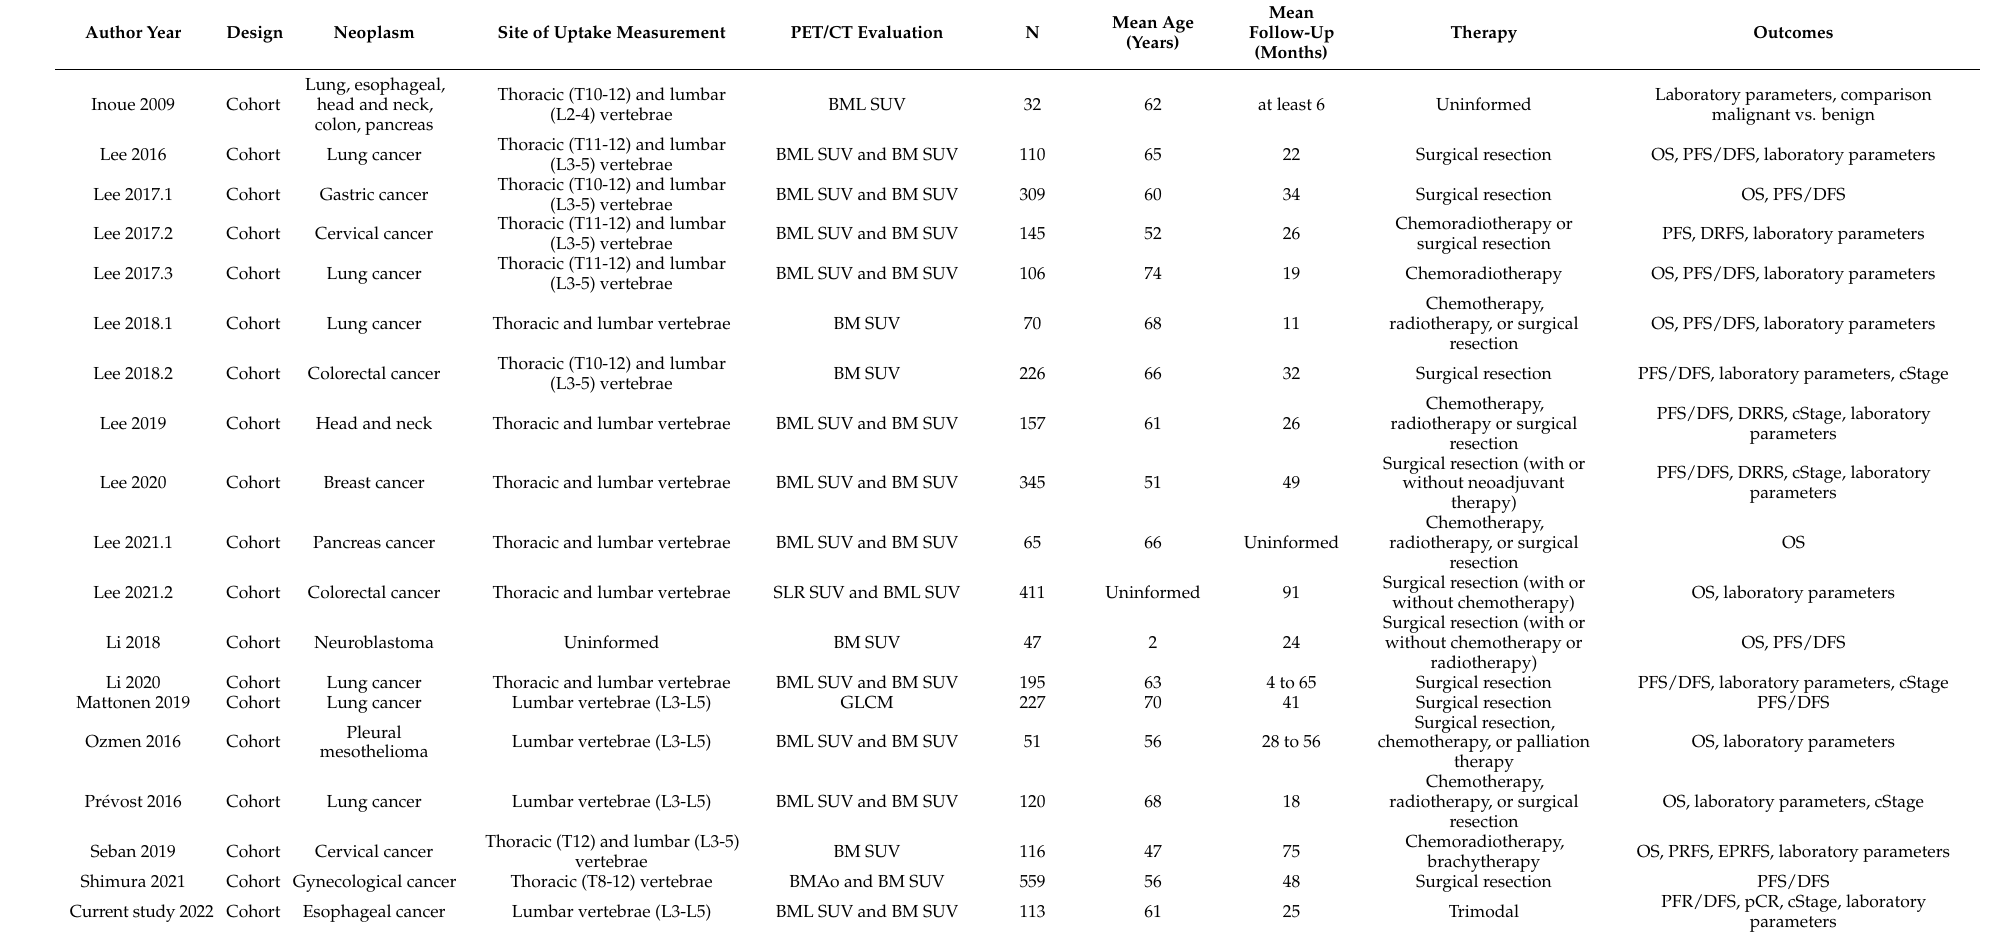
Table 5. Baseline characteristics of the included studies selected in systematic search. BML: Bone marrow-to-liver ratio; BM: Bone marrow; BMAo: Bone marrow-to- aorta ratio; OS: Overall survival; PFR/DFS: Progression-free survival or disease-free survival; GLCM: Grey Level Co-occurrence Matrix Pelvic; PRFS: Recurrence-free survival; EPRFS: Extra-pelvic recurrence free survival; pCR: pathological complete